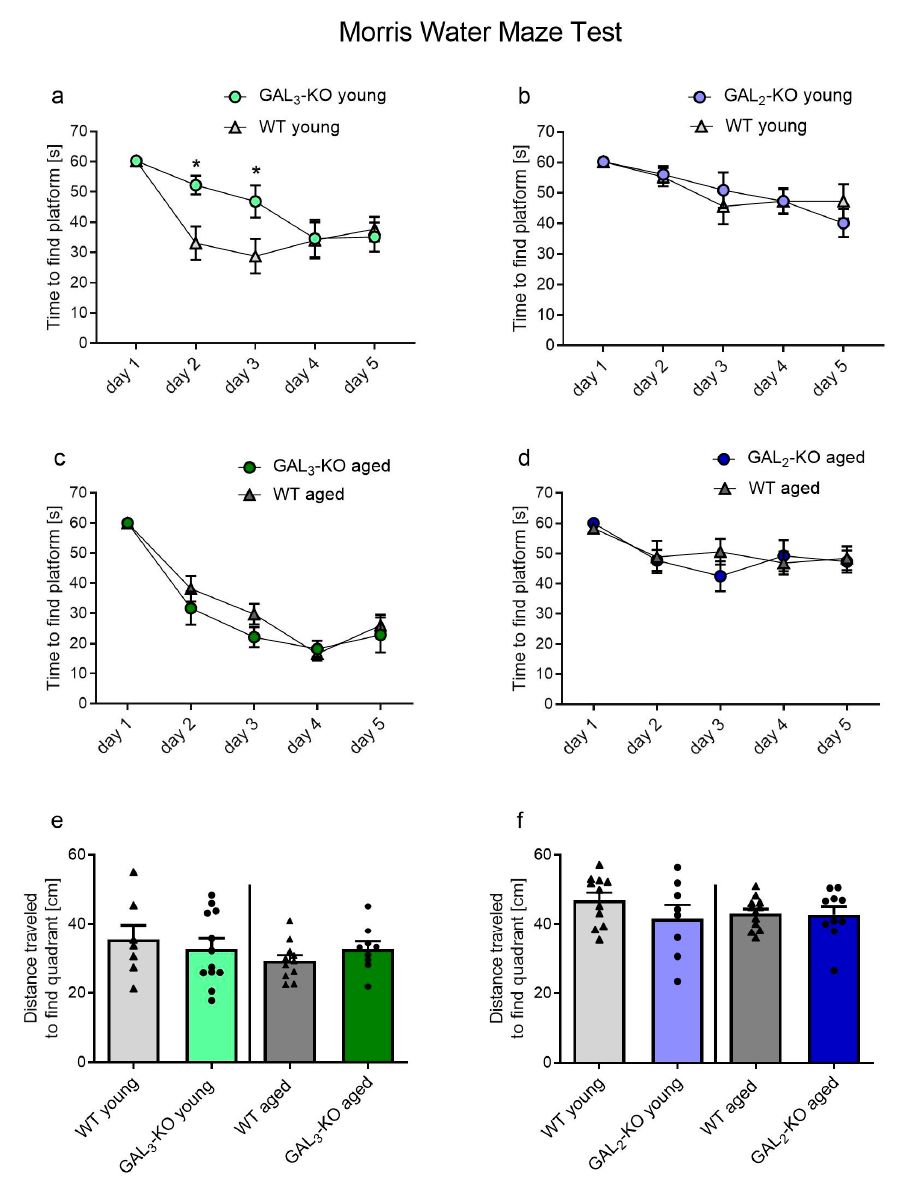
Figure 3. Behavior of GAL 2 -KO ( b , d , f ) and GAL 3 -KO ( a , c , e ) and the respective WT mice in the MWM test. Learning curves to find the platform in 3-month-old (young) ( a , b ) mice and 12–14-month-old (aged) ( c , d ) mice. ( e , f ) Memory assessment on day 6: required distance to travel to the quadrant where the platform was hidden on days 1–5 in ( e ) GAL 3 -KO and ( f ) GAL 2 -KO cohorts. Values are represented as mean ± SEM, n = 7–12 animals per group, * p < 0.05. GAL 2 -KO: GAL 2 -knockout; GAL 3 -KO: GAL 3 -knockout; WT: Wildtype; MWM: Morris Water